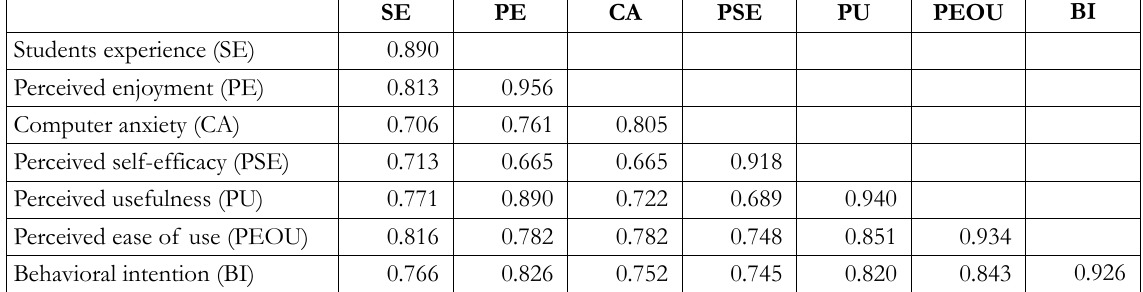
Table 3. Discriminant